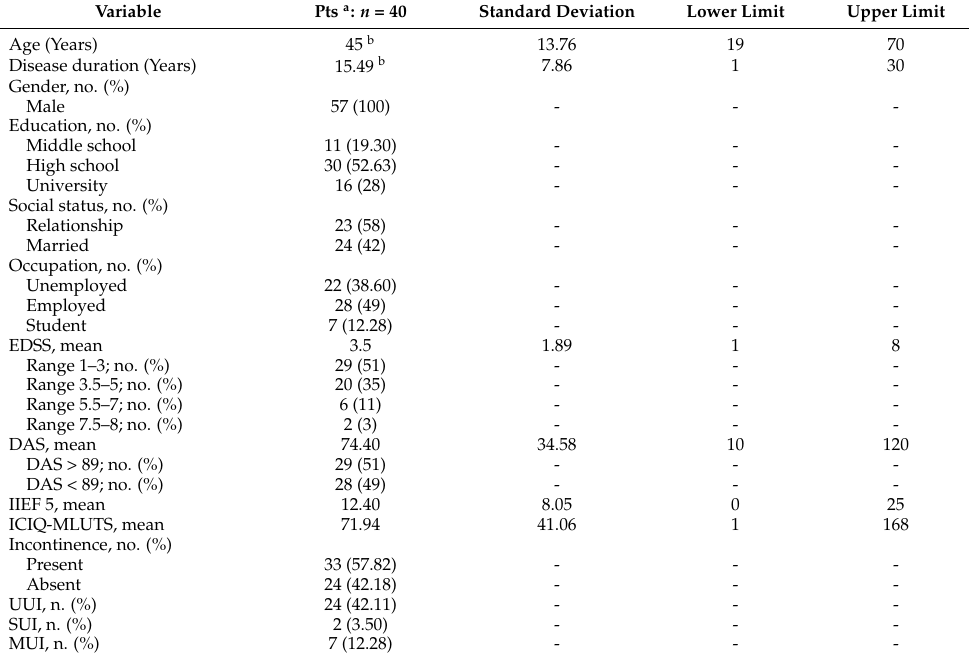
Table 1. Baseline